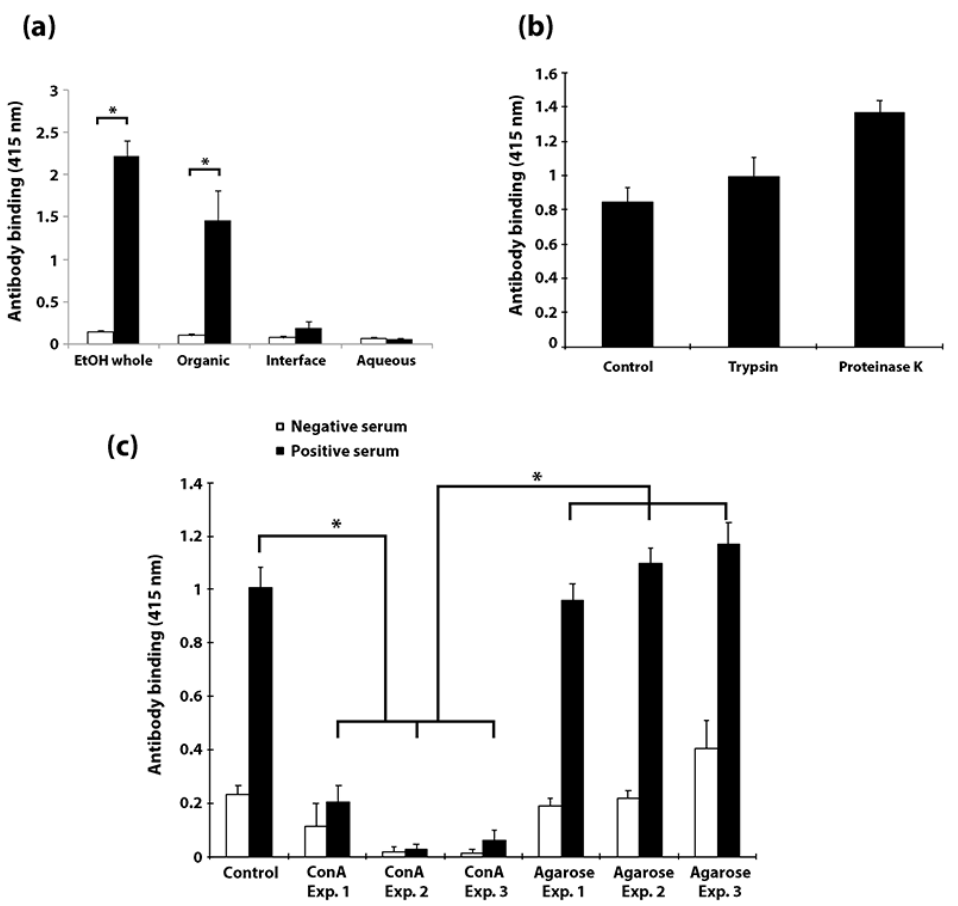
Figure 10. Bovine antibody binds to a carbohydrate component of the Map EtOH extract, not to protein. ( a ) Surface antigens of Map K-10 were extracted with 80% ethanol (EtOH Whole) and fractionated by Folch extraction method into organic (chloroform), interface and aqueous fractions. After evaporating methanol for immobilization of the lipids (and other molecules) onto the wells of a microtitre plate, they were incubated with serum samples (1:100 dilution) collected from JD-positive (solid bar) and negative (open bar) cattle. Histogram bars represent mean antibody binding ± standard deviation of quadruplicate determinations. Most of the antigenicity is in the organic fraction. ( b ) EtOH extract treated with proteases shows no negative effects on bovine antibody binding. The extract was treated with either 10 µg/mL trypsin or 10 µg/mL proteinase K with each treatment actually enhancing antibody binding. This enhancement was not statistically significant. However, EtOH extract antigens are efficiently removed by ConA-agarose as shown by lack of antibody binding ( c ). Absorption with agarose only does not affect antibody binding to the EtOH extract. This experiment was repeated in triplicate with qraduplicate measurements for each. p values less than 0.01 are denoted by an asterisk.